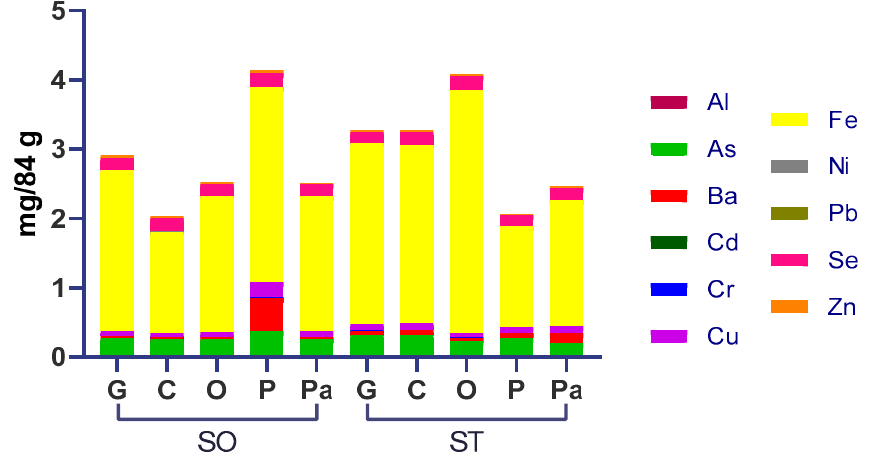
Figure 1. Elemental content distribution in canned sardines quantified by ICP OES.